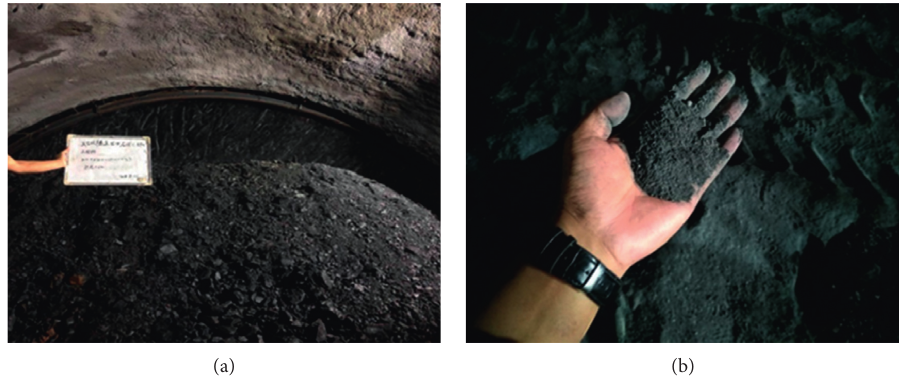
Figure 10: Loose broken rock: (a) granular carbonaceous mudstone; (b) powdery carbonaceous mudstone.